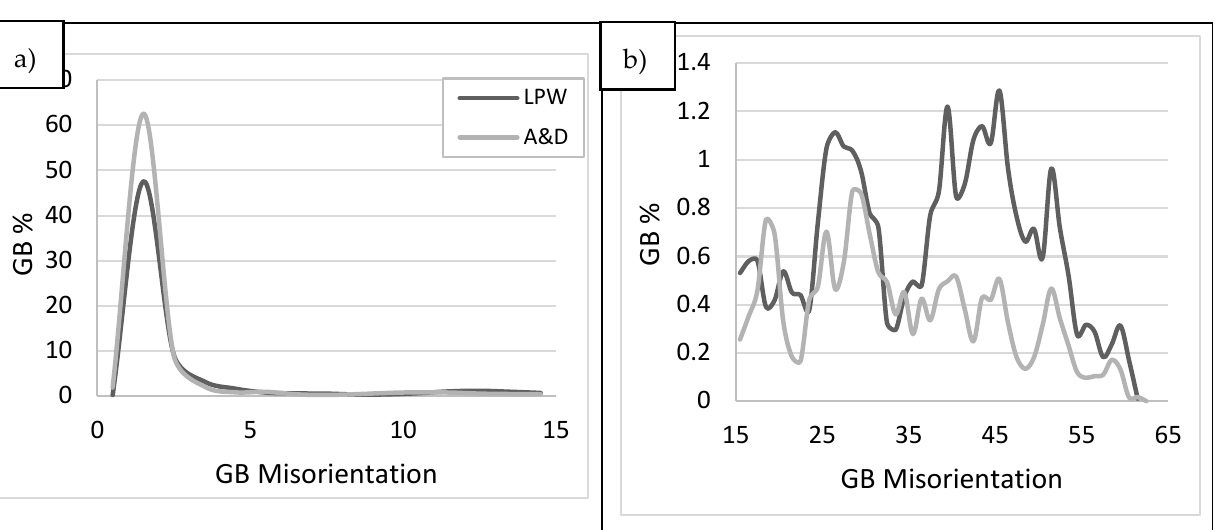
Figure 15 . LPW and A&D samples grain boundary misorientation: ( a ) LAGB and ( b ) HAGB. Rappaz et al. [37] discussed the higher crack tendency of HAGB compared to LAGB and related this fact with the dendrites coalescence behaviour. Actually, these researchers established the concept of attractive and repulsive boundaries based on the crystallographic misorientation. They stated that in the attractive GBs, secondary arms coalescence in the last stage of solidification; however, in the case of repulsive GBs, a liquid film remains stable at lower temperatures preventing the coalescence of secondary arms. In order to clarify the attractive and repulsive concepts, the researchers compared the grain boundary energy γ gb to twice the solid-liquid interface energy γ sl . Therefore, when γ gb < 2 γ sl , the liquid film will be unstable and coalescence between dendrites will occur, which is the case of attractive GB. On the other hand, in the repulsive GBs, γ gb > 2 γ sl , the liquid film remains stable at lower temperatures; thus, grain boundary remains wetted until lower temperatures. This effect could explain the increase of crack formation in the LPW sample compared to A&D sample, based on the fact that LPW sample has GBs with higher misorientation than